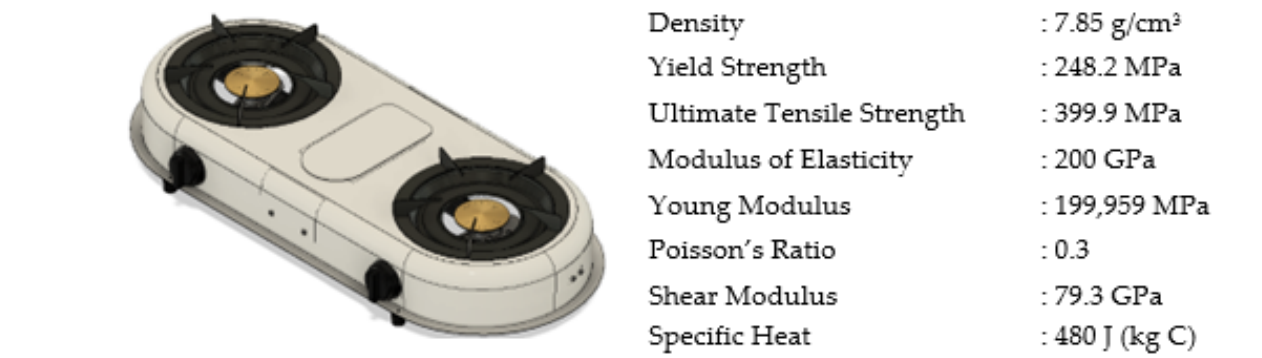
Figure 8. Specification of redesign of the two-burner stove for innovation. Table 5. CAD modelling of gas stove parts (product redesign).